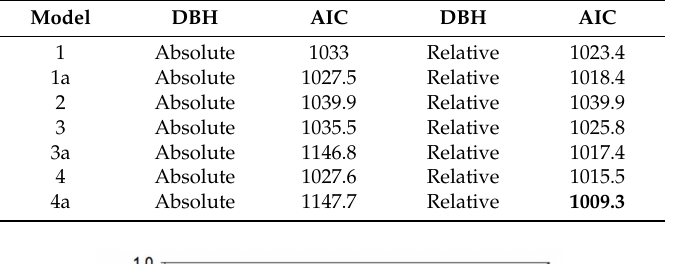
Table 1. Akaike information criterion (AIC) values for the 4 sets of models using either absolute or relative diameter (diameter at breast height (DBH)). See text for a description of the different models. The best model (lowest AIC) and alternate models within 2 units of AIC are identified in bold.